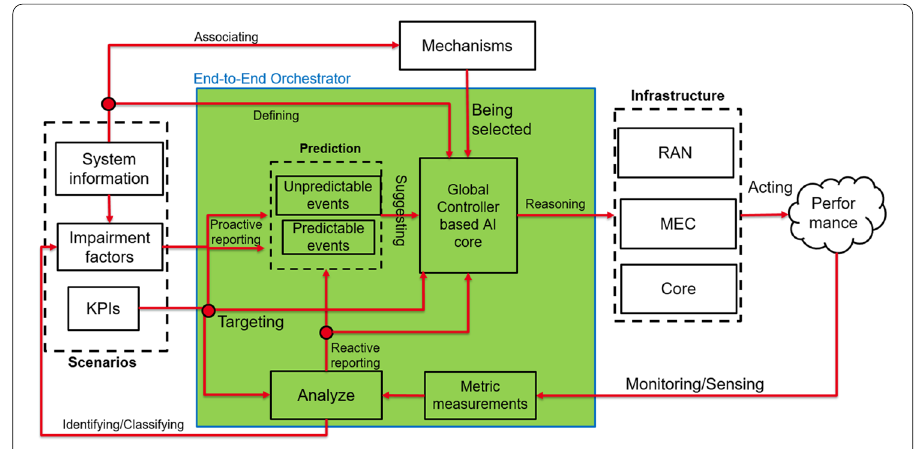
Fig. 17 Framework to design a E2E orchestration